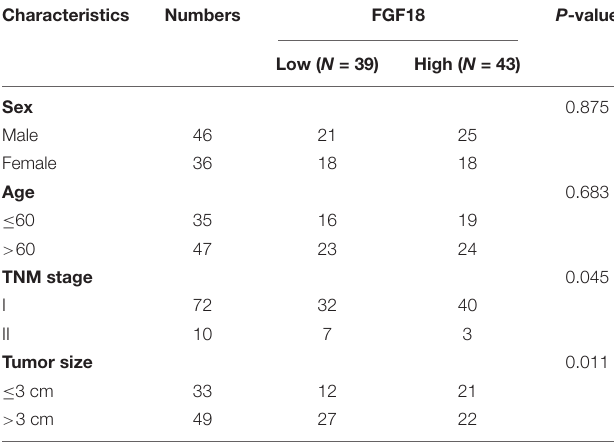
TABLE 1 | The clinic-pathological factors of 82 KIRC patients.